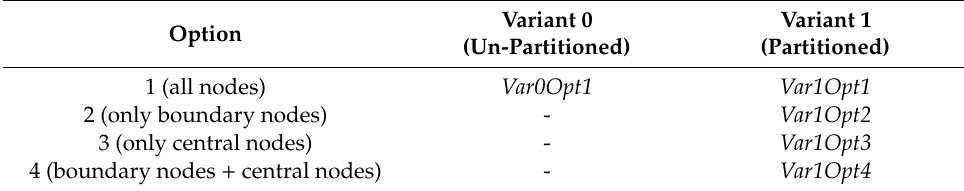
Table 1. Framework of optimizations for sensor placement in the Parete